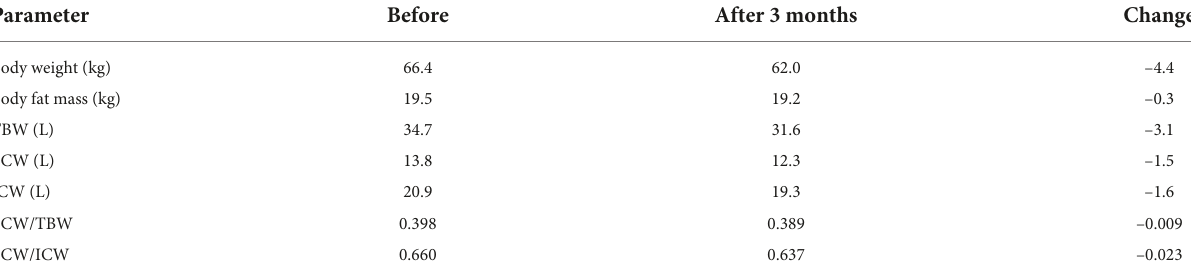
TABLE 2 Changes in body fluid balance before and after SGLT2i administration.